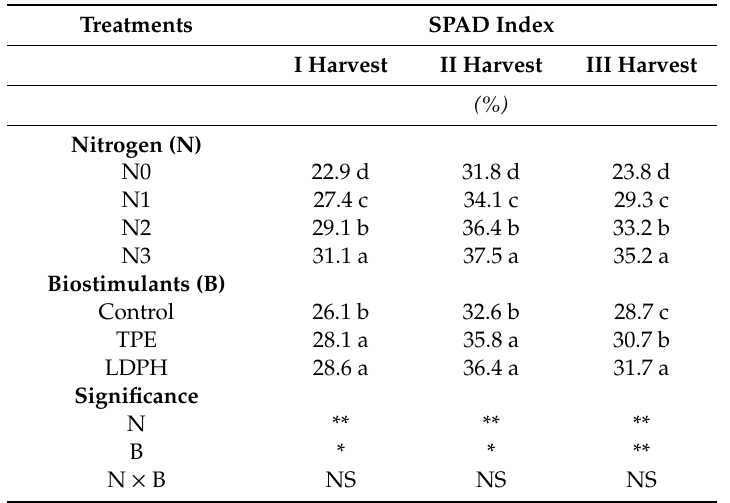
Table 3. Baby rocket leaf plants Soil Plant Analysis Development (SPAD) index at di ff erent harvest dates in relation to N fertilization rates (N0 = 0, N1 = 60, N2 = 80, and N3 = 100 kg ha − 1 ) and biostimulant application (Control, tropical plant extract (TPE): Auxym and legume-derived protein hydrolysate (LDPH):